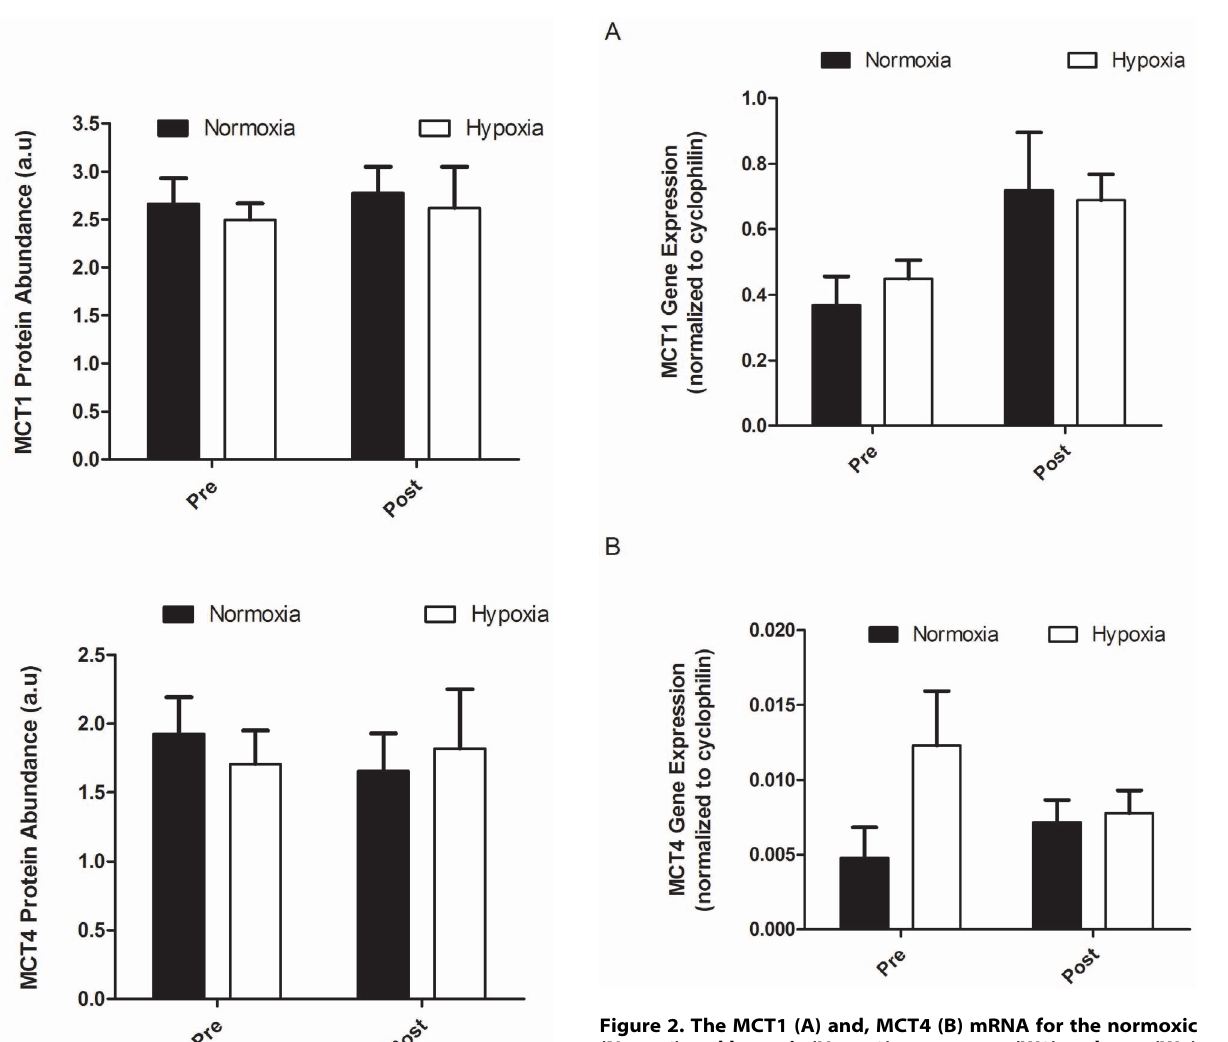
Figure 2. The MCT1 (A) and, MCT4 (B) mRNA for the normoxic (N; n=6) and hypoxic (H; n=8) groups, pre (W0) and post (W4) the 3 wk IHT period.